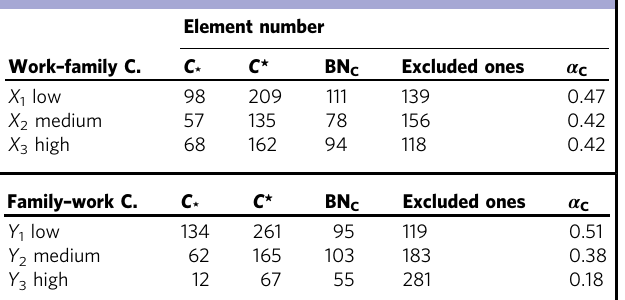
Table 3 Lower/upper approximations and boundary sets of the fi rst stage.